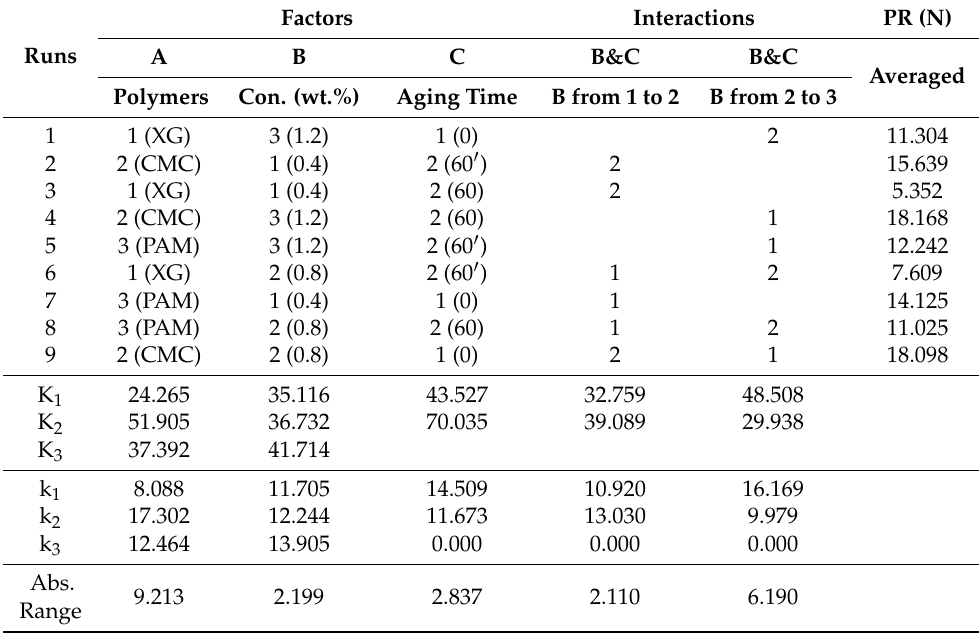
Table 3. Orthogonal data analysis of self-aging test for individual polymer application. Factors Runs